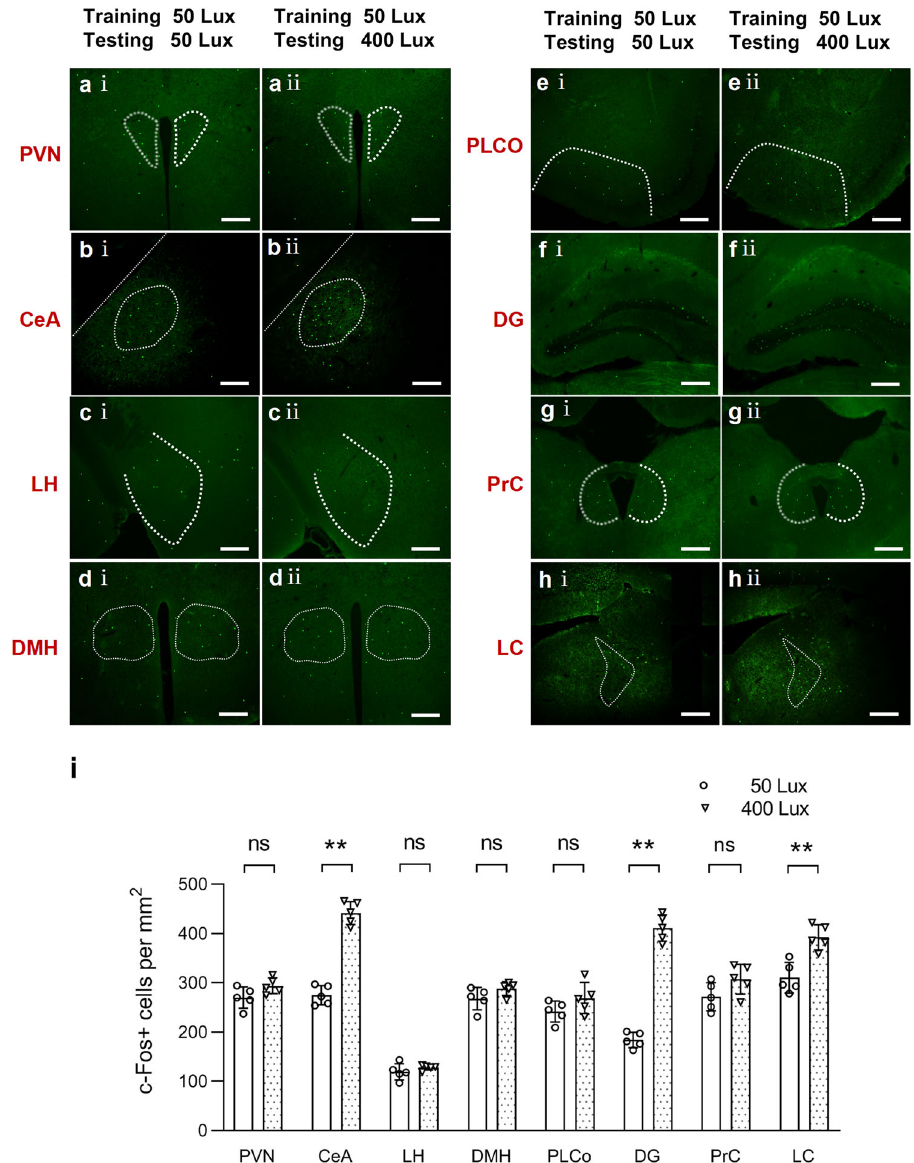
Fig. 2 Expression of c-Fos in the brain after light exposure in the Y-maze test. Representative images of immuno fl uorescence staining of c-Fos in different brain regions of mice after 50 lux light exposure during both training and testing period ( a (i), b (i), c (i), d (i), e (i), f (i), g (i), and h (i)), and that after receiving 50 lux light exposure during the training period and 400 lux light exposure during the testing period ( a (ii), b (ii), c (ii), d (ii), e (ii), f (ii), g (ii), and h (ii)). Scale bars: 200 μ m. i Quanti fi cation of c-Fos + neurons in each brain region. ns: not signi fi cant; ** P < 0.01, P > 0.05 not signi fi cant vs. 50 lux group, two independent sample t-test, n = 5/group. CeA: central amygdaloid nucleus; LC: locus coeruleus; DG: dentate gyrus; PrC: